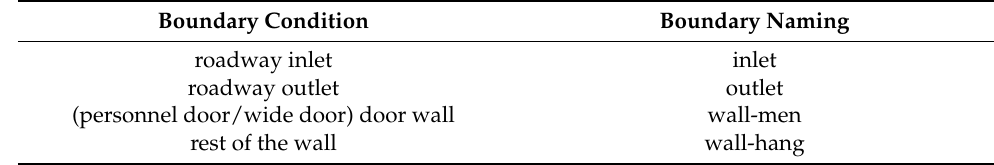
Table 9. Boundary conditions of three-dimensional roadway model.